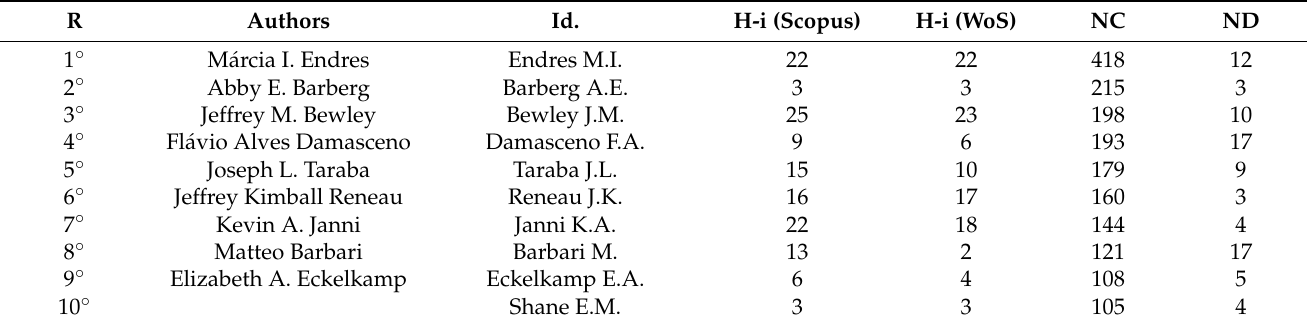
Table 3. Top ten relevant authors of publications on compost barn from 2007 to 2022/April.